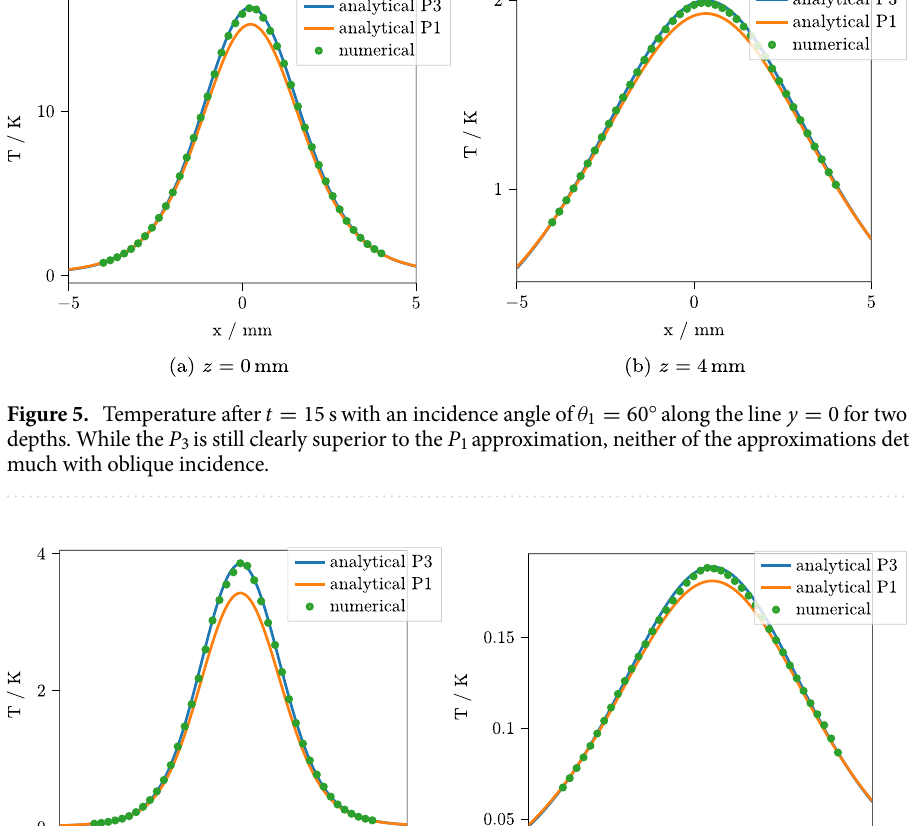
1 s with an incidence angle of θ 1 =